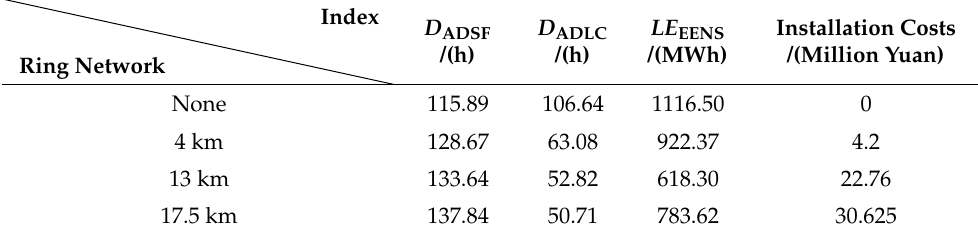
Table 9. Comparison of indexes before and after the ring